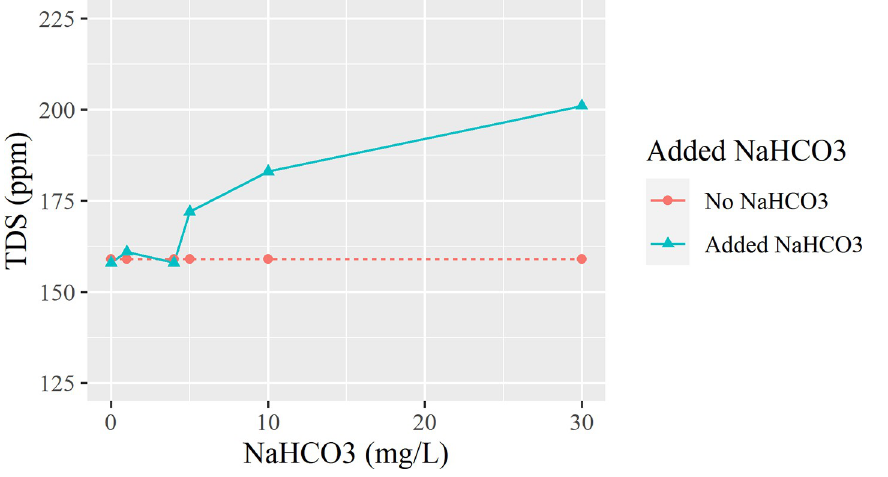
Fig 8. Trend for the effect of NaHCO3 on